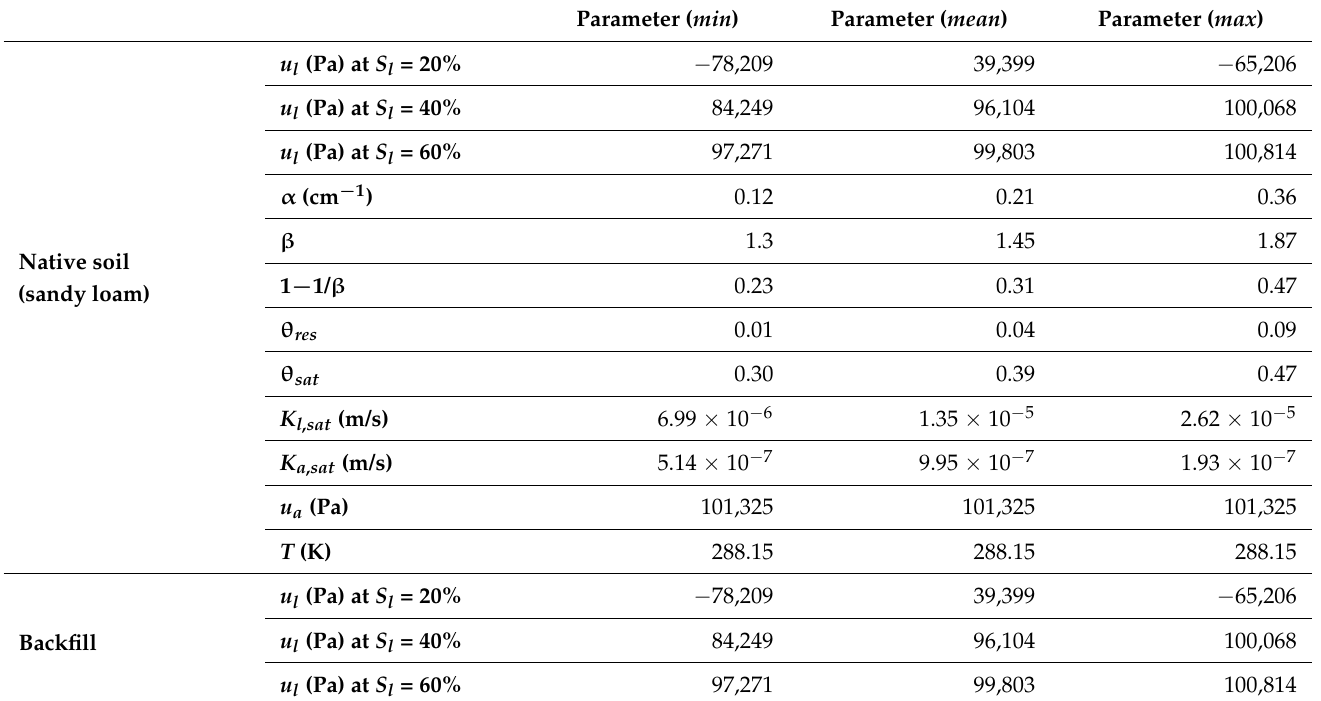
Table 6. Initial input for batch simulation of BRU location (adopted from [48]).